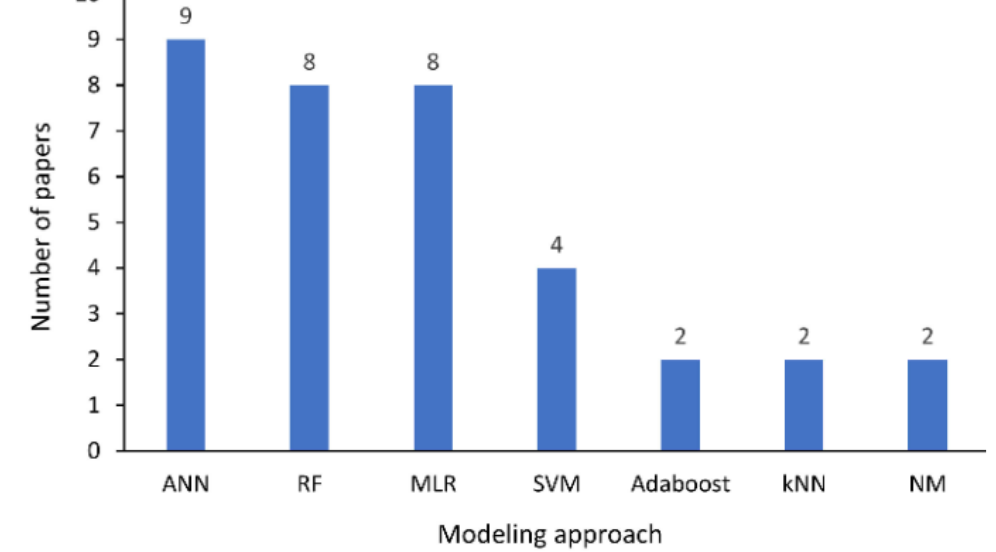
Figure 4. Machine learning (ML) Techniques used the most from 2019–2021 [32]. ANN refers to